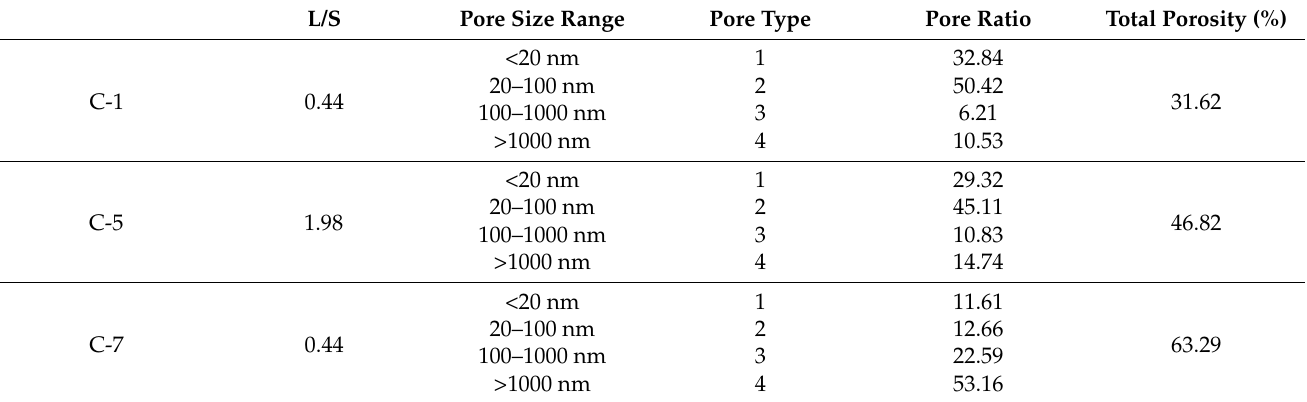
Table 5. Pore distribution law of the